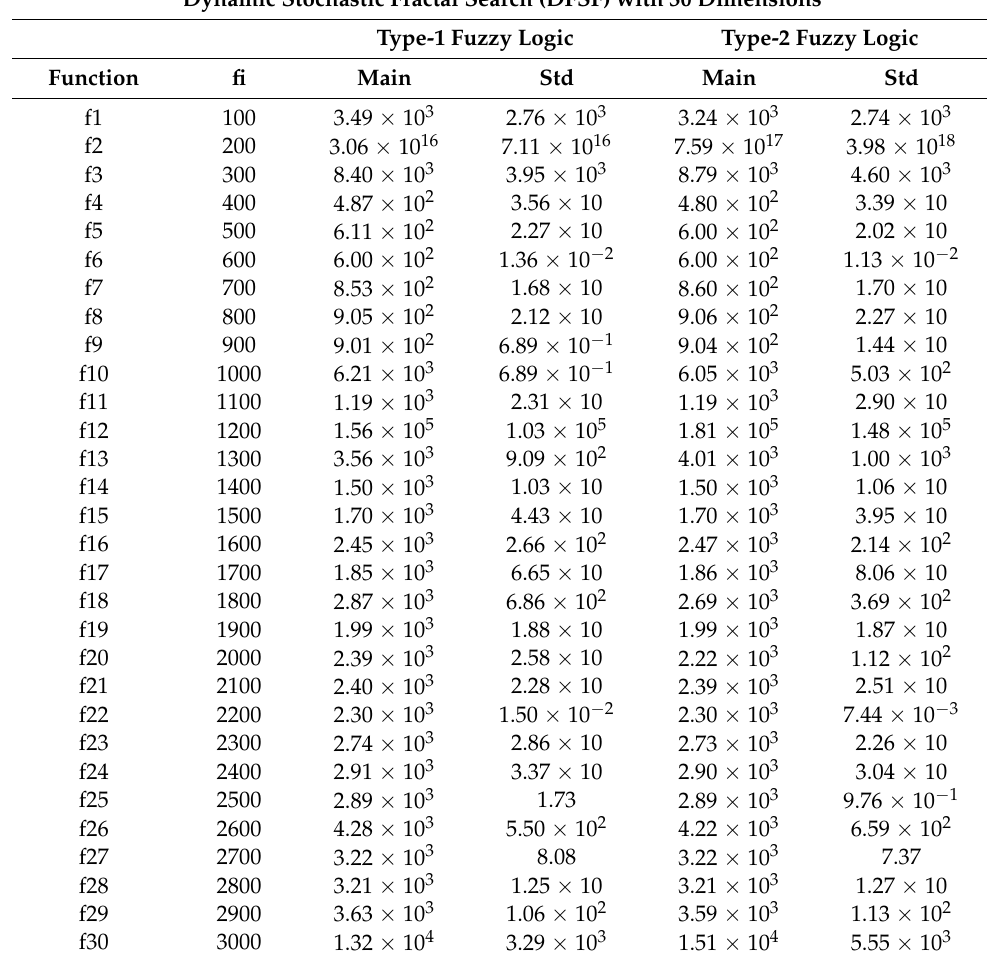
Table 3. Dynamic Stochastic Fractal Search (DSFS) results with 30